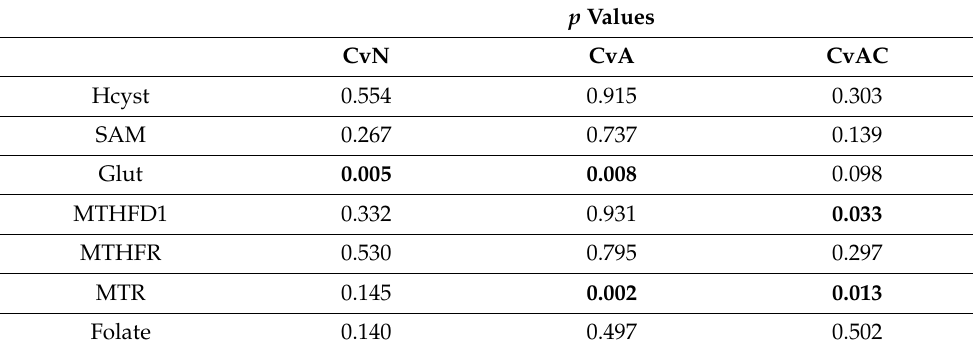
Table 7. T -tests of